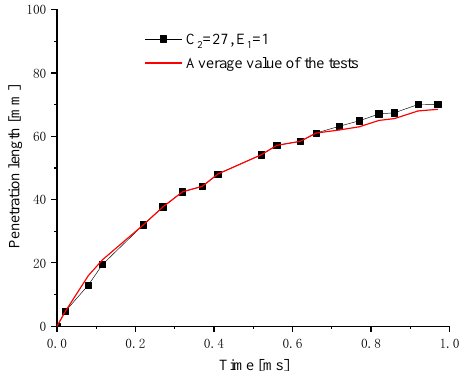
Figure 11. Comparison of the vapor penetration length between the simulated and experimental results.